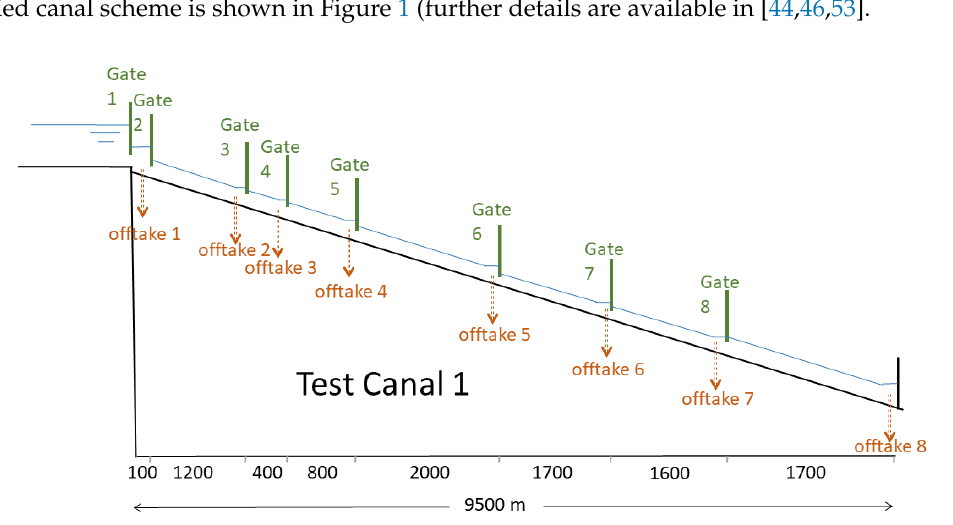
Figure 1. Profile of the ASCE Test Canal 1 taken